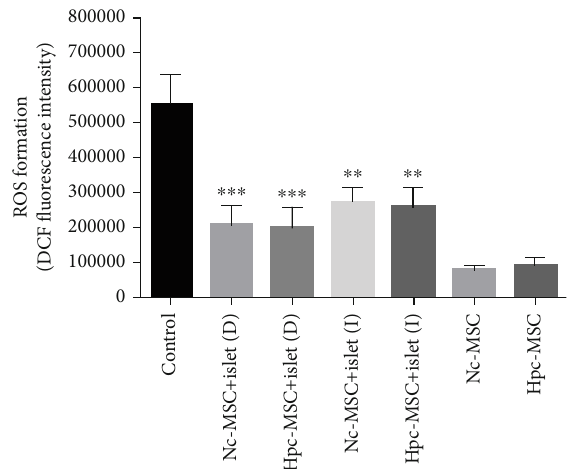
Figure 9: ROS production in human islets cocultured with Hpc- MSCs and Nc-MSCs. The chart shows ROS formation based on DCF fl uorescent intensity. A comparison was done between the control and each cocultured islets. ∗∗ P < 0 : 01 and ∗∗∗ P < 0 : 001 . Nc-MSCs: normoxia condition mesenchymal stem cells; Hpc- MSCs: hypoxia preconditioning MSCs; D: direct coculture; I: indirect